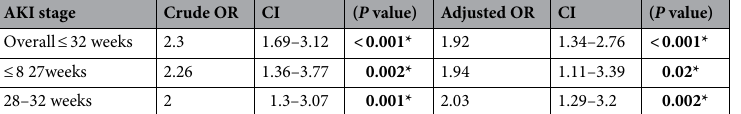
Table 3. Multivariable ordinal logistic regression for the association between IVH grades and AKI stages; overall and stratified by GA (n = 710). Abbreviations: IVH intraventricular hemorrhage, AKI acute kidney injury, GA gestational age, OR odds ratio, CI confidence interval. *Statistically significant at 5% level. Bold values indicate all values less than 0.05 are significant.